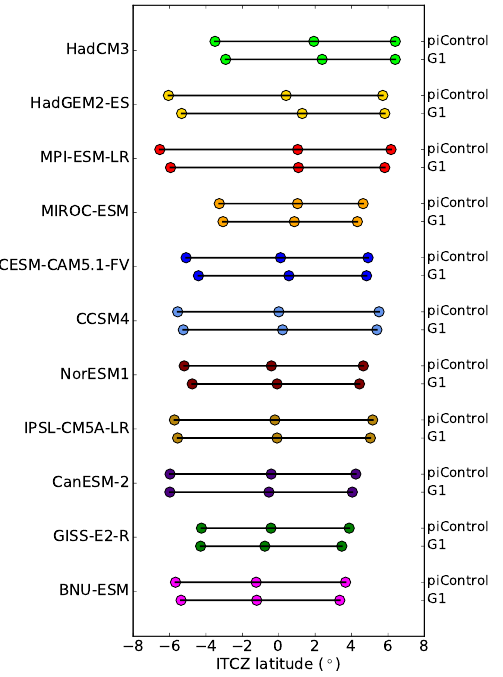
Figure 10. The annual and seasonal mean positions of the ITCZ in piControl (years 1–40) and G1 (years 11–50). For each model, the top row of dots shows the piControl positions, and the bottom row of dots shows the G1 positions. In each row of dots, the left dot shows the JFM mean position, the middle dot shows the annual mean position, and the right dot shows the JAS mean position. The models are ordered by the annual mean ITCZ position in